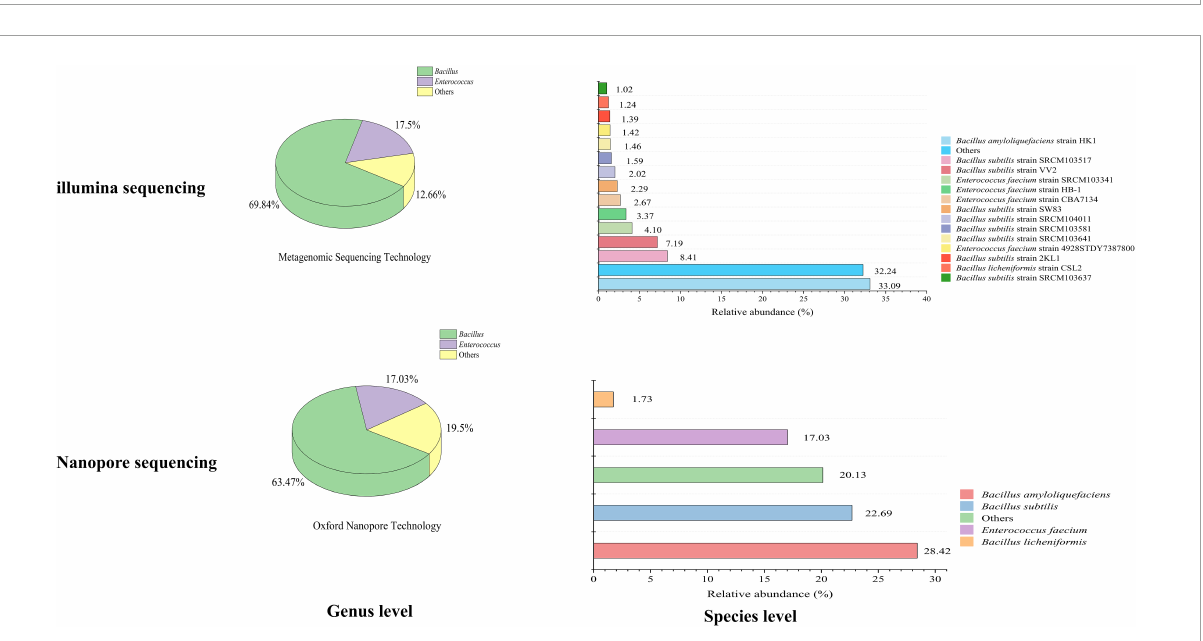
FIGURE3 Relative abundance of microorganisms in inbound environmental protection microbial inoculants using illumina and nanopore sequencing. Genus level (left) and species level (right) .